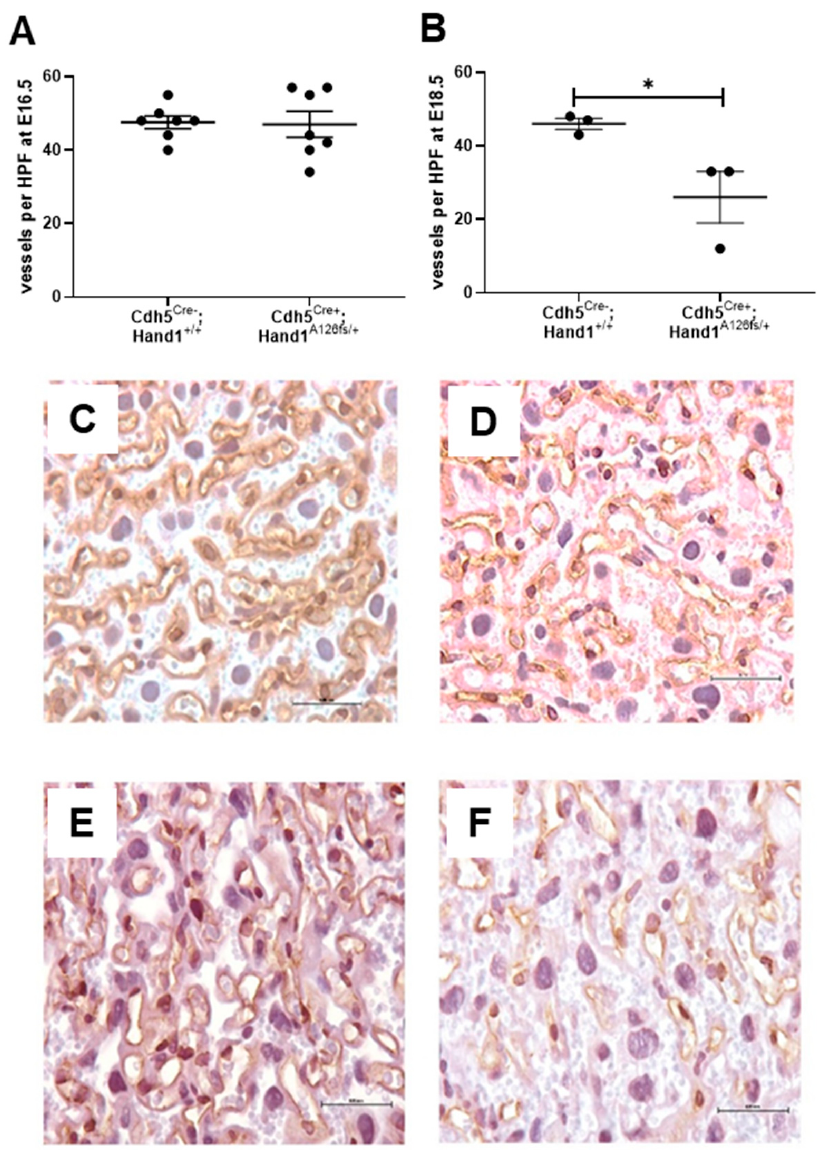
Figure 8. Fetal vessel density in the placenta labyrinth at embryonic day 16.5 (E16.5) and E18.5 between wildtype ( Cdh5 Cre − ;Hand1 +/+ ) and Cdh5 Cre+ ;Hand1 A126fs/+ placentas. ( A ) At E16.5 there was no difference in the number of fetal vessels per high powered field (HPF) between Cdh5 Cre − ;Hand1 +/+ and Cdh5 Cre+ ;Hand1 A126fs/+ placentas; ( B ) At E18.5, the number of fetal vessels per HPF was reduced in the labyrinth of the Cdh5 Cre+ ;Hand1 A126fs/+ placentas compared to wildtype; ( C , D ) are representative images at E16.5 and E18.5 of a Cdh5 Cre − ;Hand1 +/+ placenta, respectively. ( E , F ) are representative images at E16.5 and E18.5 of a Cdh5 Cre+ ;Hand1 A126fs/+ placenta, respectively. Data are mean ± SEM; ( A , B ) individual dots represent average per litter. n = 3–4 litters per time point. Statistical significance determined using a students t -test. * P < 0.05. CD-31 staining (brown) with hematoxylin counterstain. Scale bars = 500 µm.